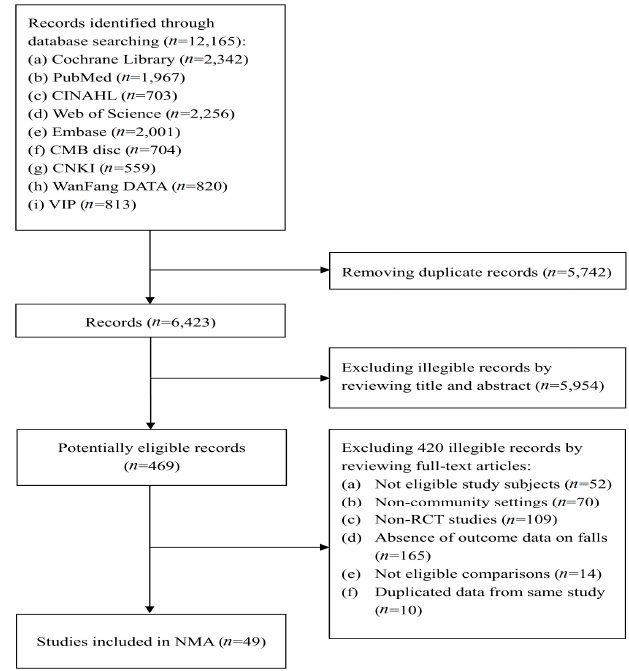
Figure 1. Flow diagram of study selection in systematic review of fall prevention interventions. Note: Abbreviations: 1. Embase: Excerpta Medica Database; 2. CINAHL: Cumulative Index to Nursing and Allied Health Literature; 3. CMBdisc: China Biology Medicine disc; 4. WanFang DATA: WanFang Data Knowledge Service Platform 5. VIP: VIP Database for Chinese Technical